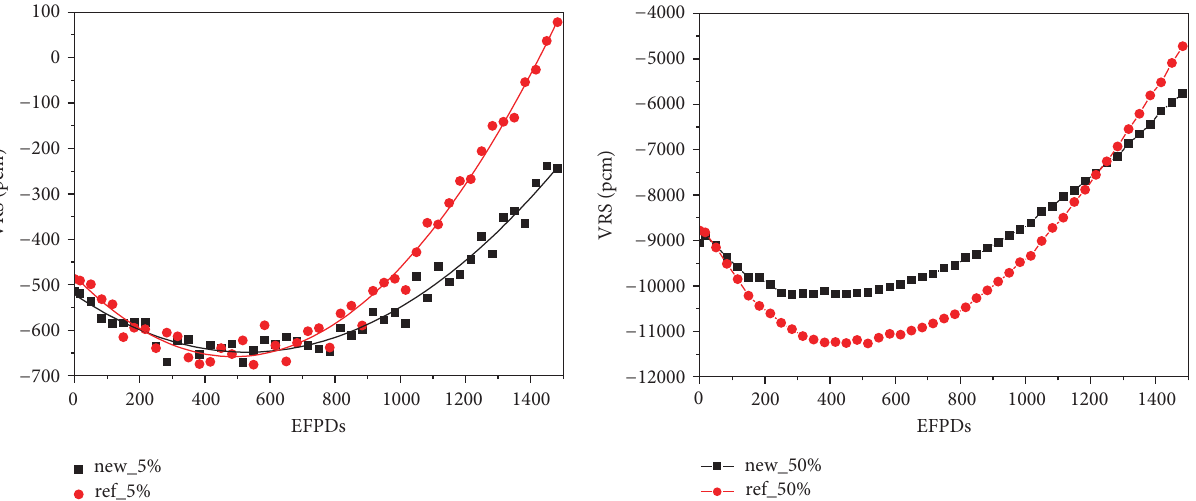
Figure 18: VRS for 5% and 50% void.